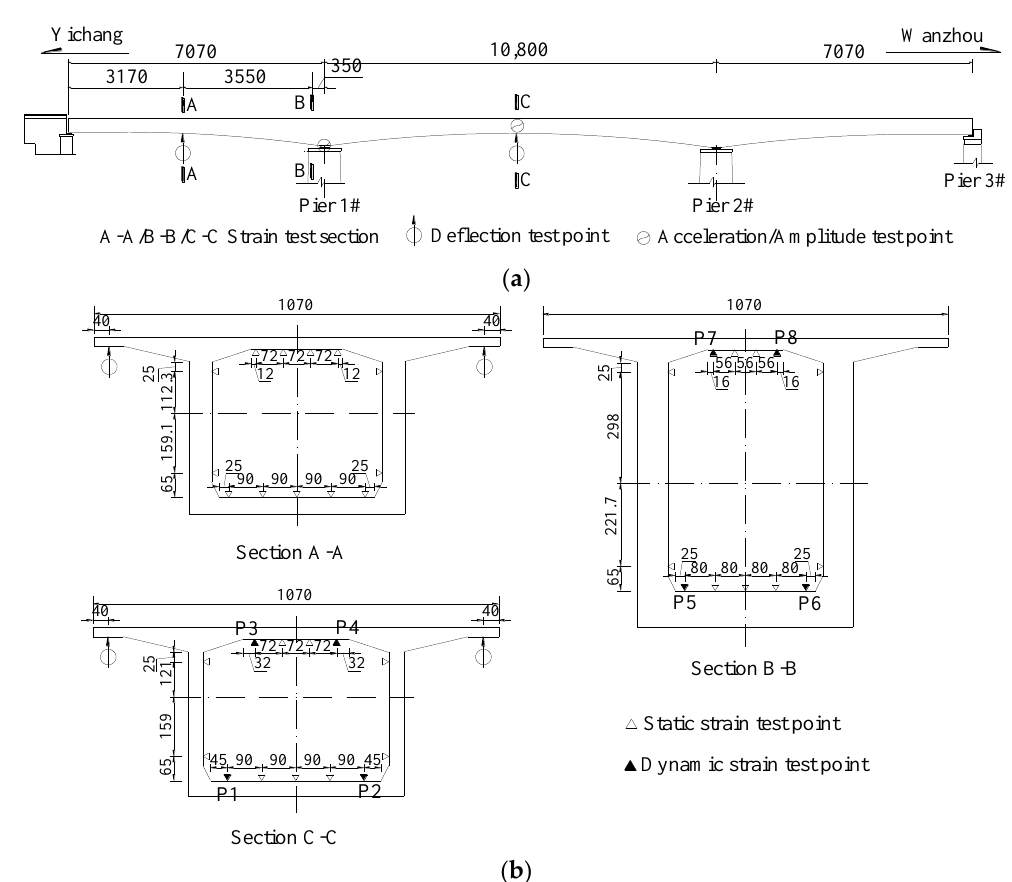
Figure 1. The Yexihe Bridge (unit: cm): ( a ) elevation view; ( b ) cross sections of A-A to C-C.